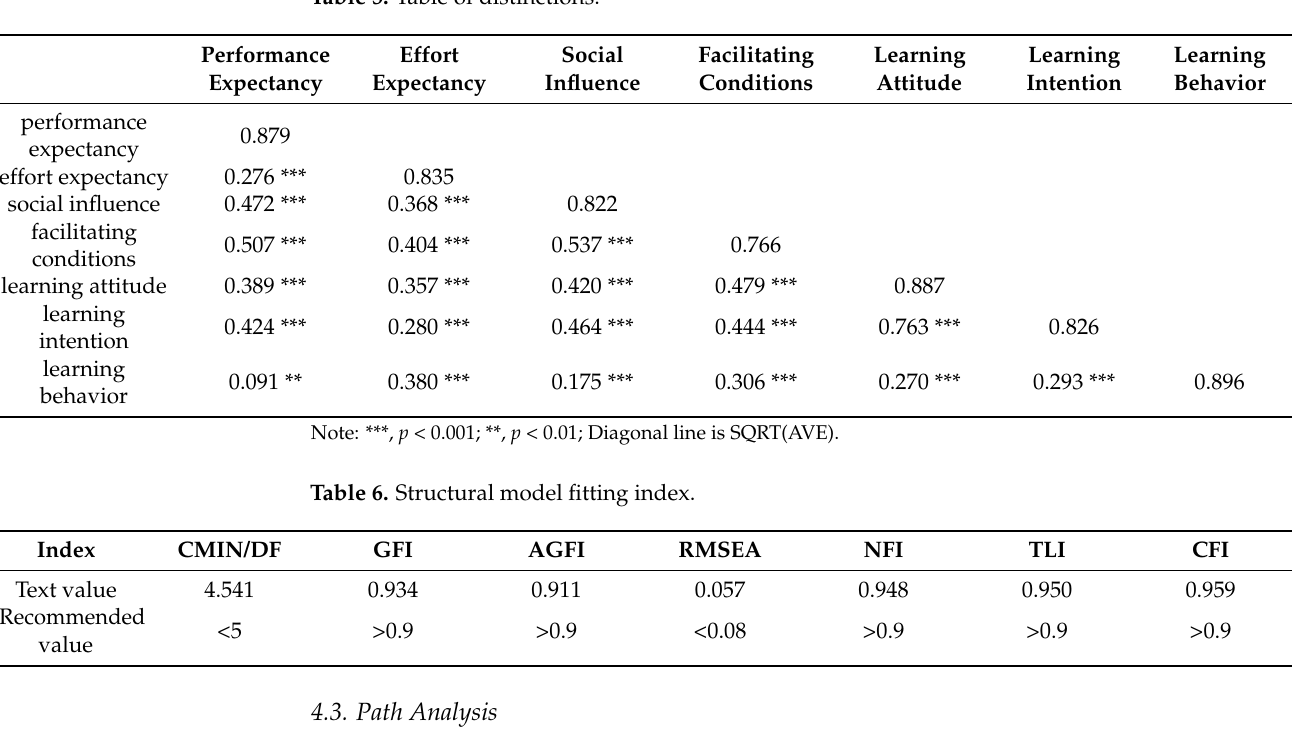
Table 5. Table of distinctions.